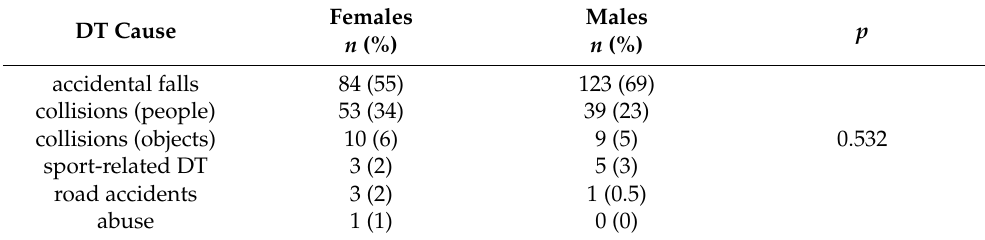
Figure 3. Distribution of DT according to Andreasen’s classification. DT causes are shown in Table 1. The most common were accidental falls and collisions. No significant differences in DT causes and setting were found regarding gender (Table 1). Table 1. Distribution of DT depending on the cause.